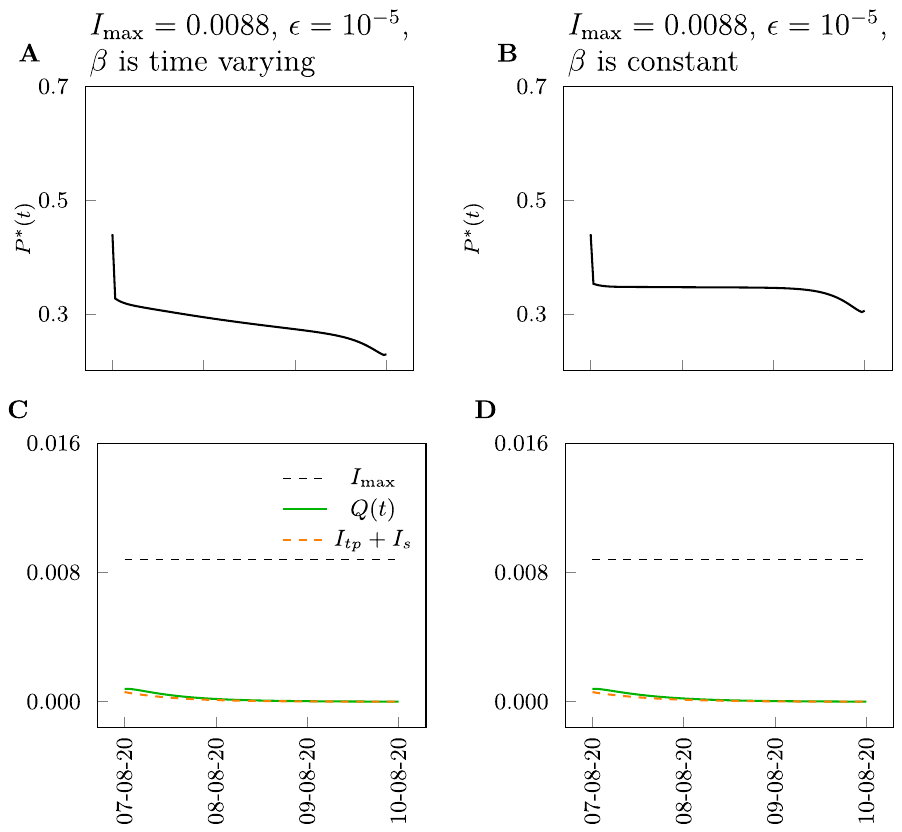
Figure 6. Time-varying transmissibility. We consider the NYC Metropolitan Statistical Area. Left plots: time- invariant transmissibility. Right plots: the transmissibility increases linearly in time. As can be seen, with the exception of the initial phase and of the final phase, the case of linearly increasing transmissibility corresponds to a linearly decreasing optimal control input P ∗ ( t )